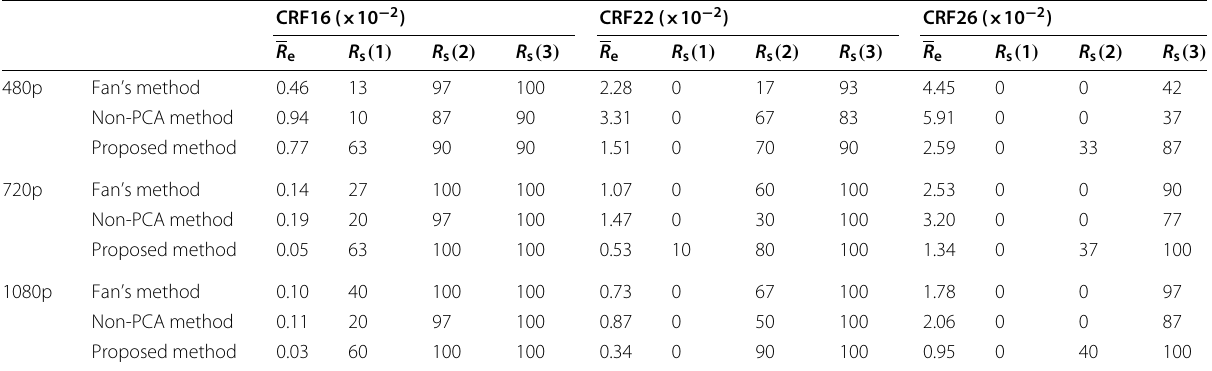
Table 3 The average BER R e and successful extraction rate R s after videos are transcoded by the video transcoder with a CRF value